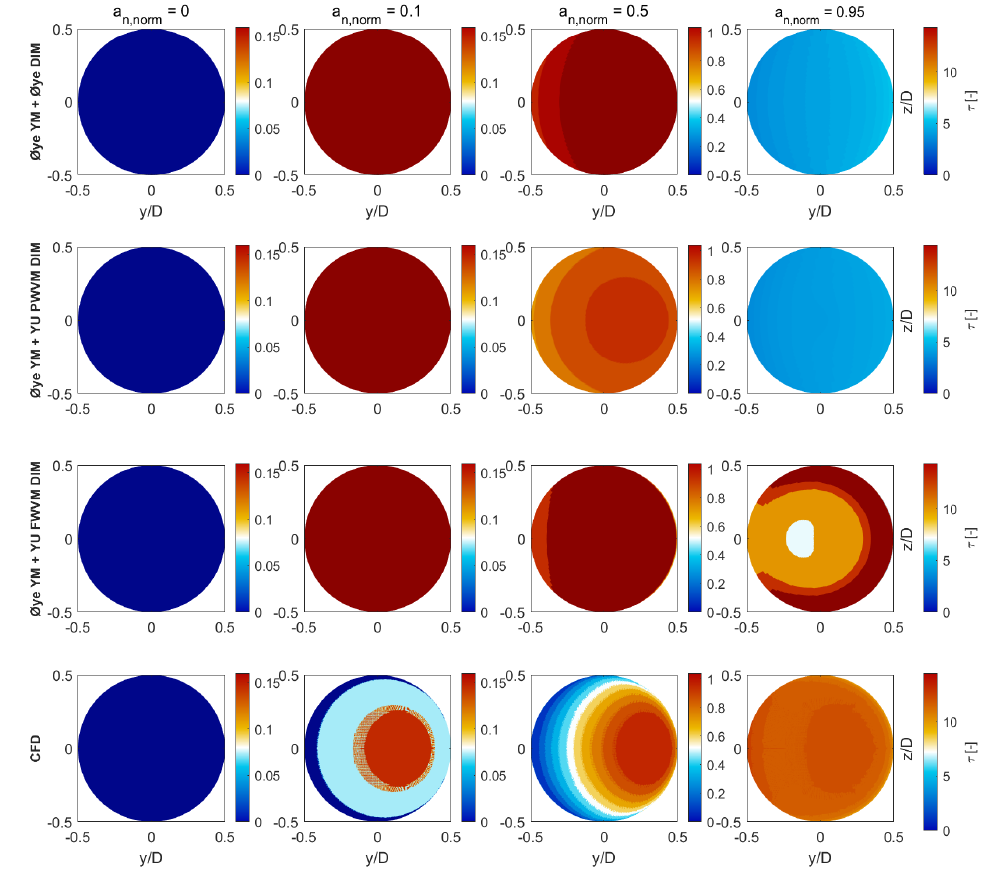
Figure 17. Varying τ at the a n , norm of center = 0.0, 0.1, 0.5, 0.95 from different models when step ∆ C Φ y = 30 T = +0.1,